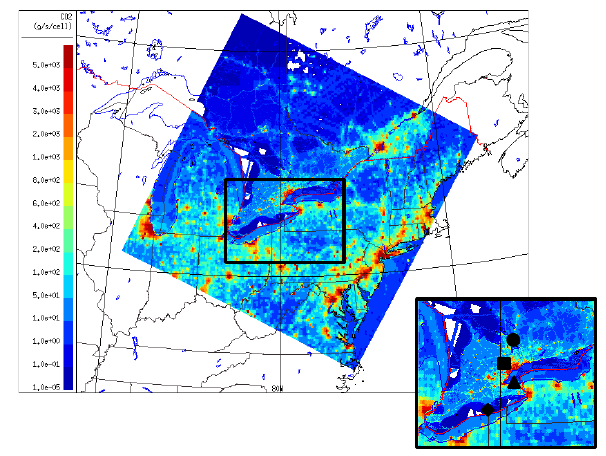
Figure 1. Total anthropogenic CO 2 emissions for a weekday in February 2010 estimated by the SOCE inventory for the province of Ontario and by the FFDAS v2 inventory for the remainder of the GEM-MACH PanAm domain. Locations of in situ measurements of CO 2 in the Southern Ontario Greenhouse Gas Network are shown in the inset (Downsview is a square, Egbert is a circle, Hanlan’s Point is a triangle, Turkey Point is a diamond). The Downsview and Han- lan’s Point sites are both located in the GTA. Unit: gCO 2 s − 1 grid cell − 1